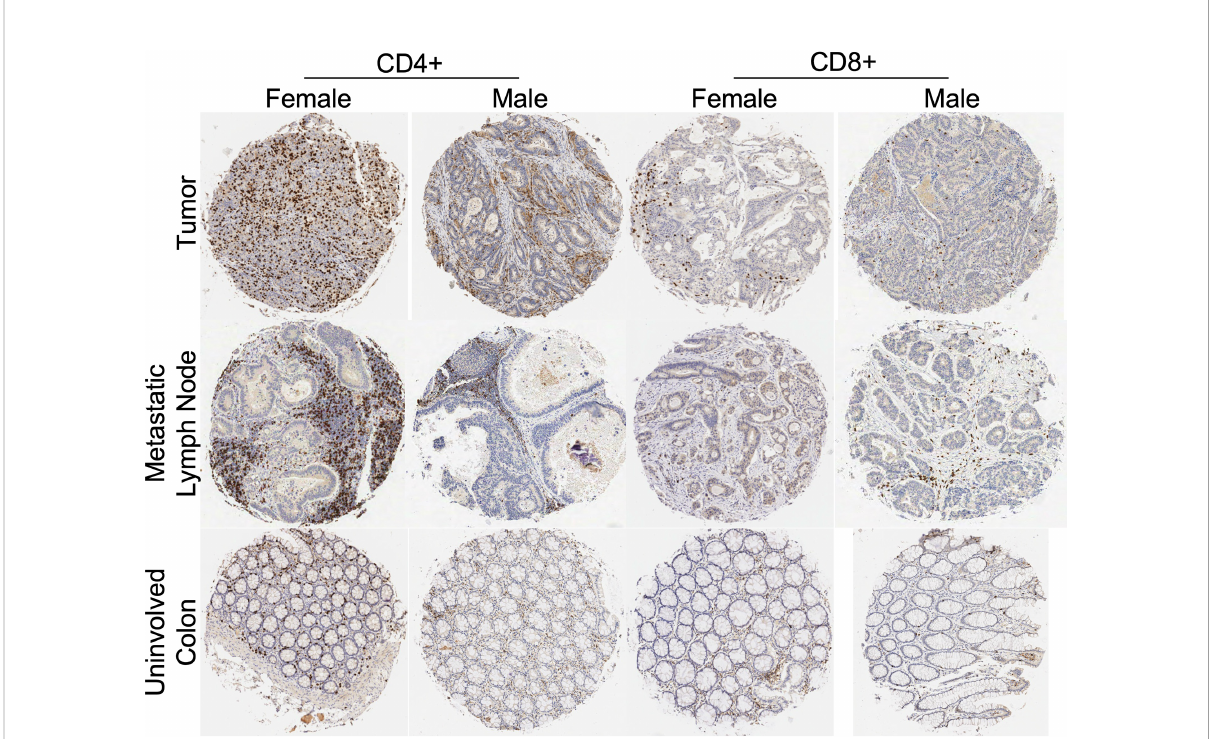
FIGURE 1 Tissue microarray histologic representations of colon tumor tissue, metastatic lymph node, and uninvolved colon from female and male patients after immunohistochemistry staining for CD4+ and CD8+ antibodies. Tissue from tumor specimens (top row), tissue from involved lymph node specimens (middle row) and tissue from uninvolved colon specimens (bottom row). Representative IHC from a female and male patient with stage III